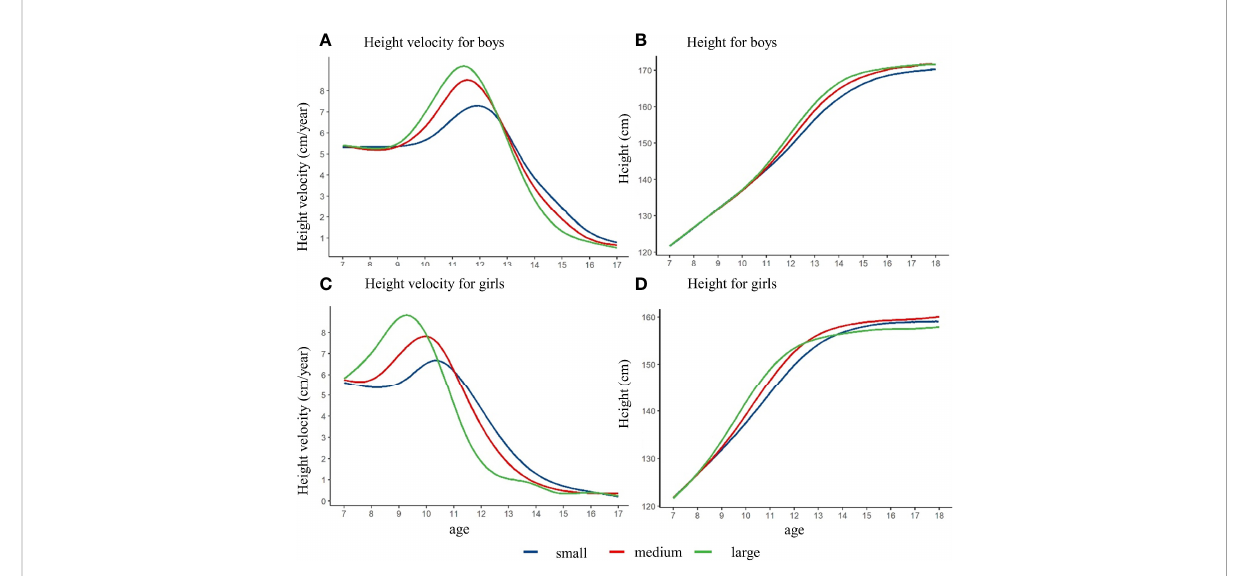
FIGURE 3 The height growth trajectory of boys and girls with different height spurt intensity (PHV) after matching the pre-pubertal height at baseline. (A) height velocity for boys; (B) height for boys; (C) height velocity for girls; (D) height for